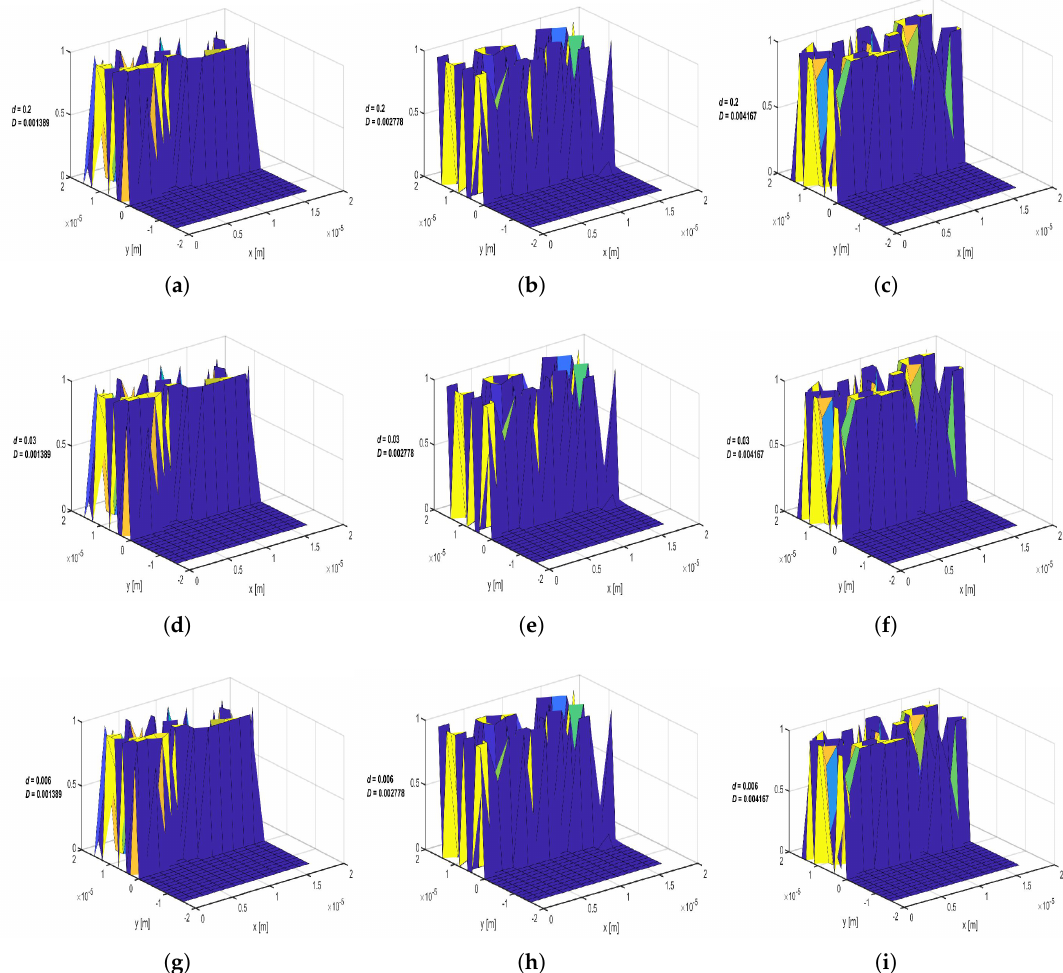
Figure A5. Concentration distribution within the porous media with variable linear drift ratio and dispersion coefficients correspond to ( a ) d = 0.2, D = 0.001389 ( b ) d = 0.2, D = 0.002778 ( c ) d = 0.2, D = 0.004167 ( d ) d = 0.03, D = 0.001389 ( e ) d = 0.03, D = 0.002778 ( f ) d = 0.03, D = 0.004167 ( g ) d = 0.06, D = 0.001389 ( h ) d = 0.06, D = 0.002778 ( i ) d = 0.06, D = 0.004167 at a period of 70